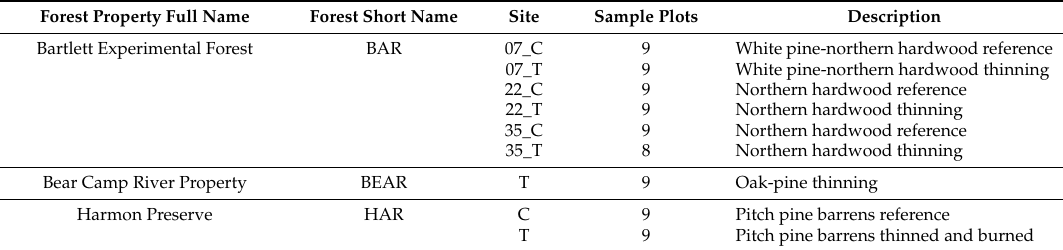
Table 1. Forest, sites, and